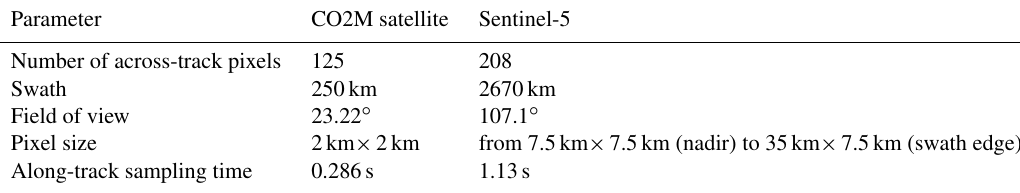
Table 3. Observation geometries for instruments on the CO2M satellite and Sentinel-5 used in this study. Note that some parameters can differ from the real satellites (see text for